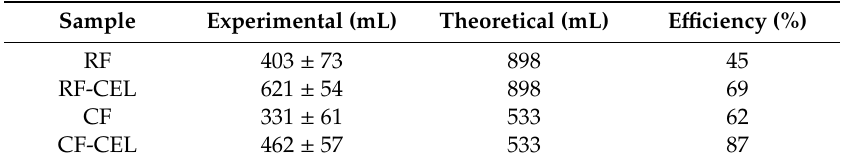
Figure 5. Average biomethane production for raw feed (RF) and centrifuged feed (CF), with and without cellulase, and two blank cases. Table 5. Comparison of theoretical (assuming complete feed COD conversion) and experimental methane productions.